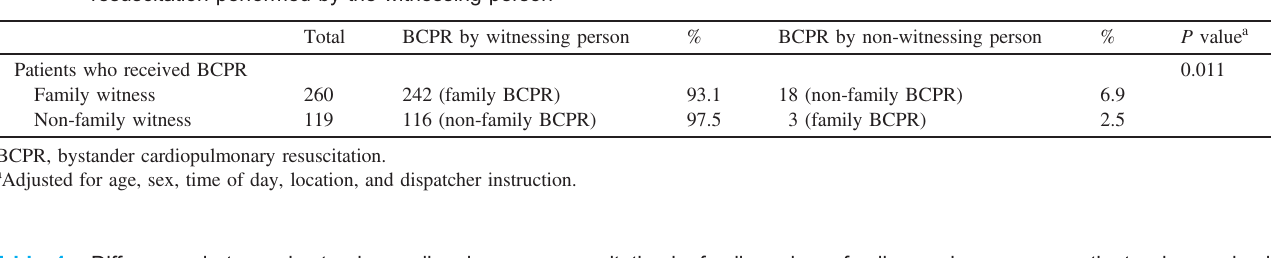
Table 2. Bystander cardiopulmonary resuscitation according to the witnessing person Total Bystander CPR % P value a